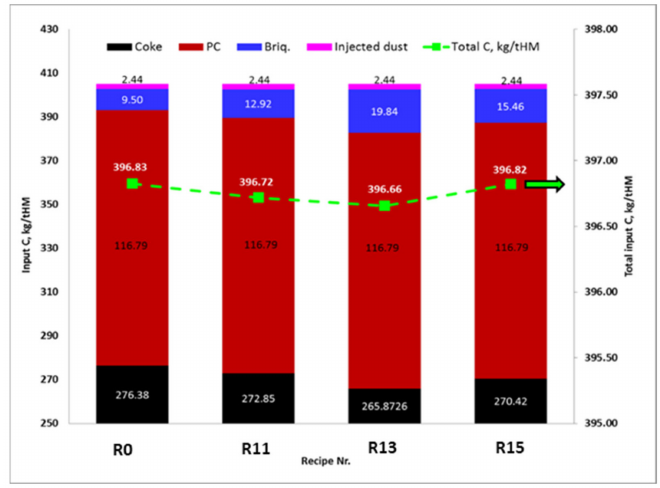
Figure 10. Source of input carbon form different charged